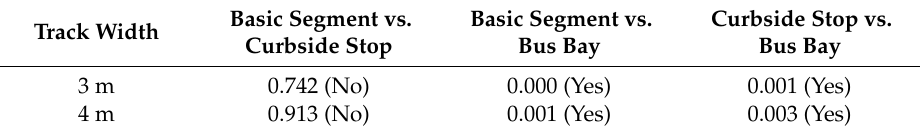
Table 4. t -Tests Results of the Di ff erences in Speeds at Di ff erent Cycle Track Widths.